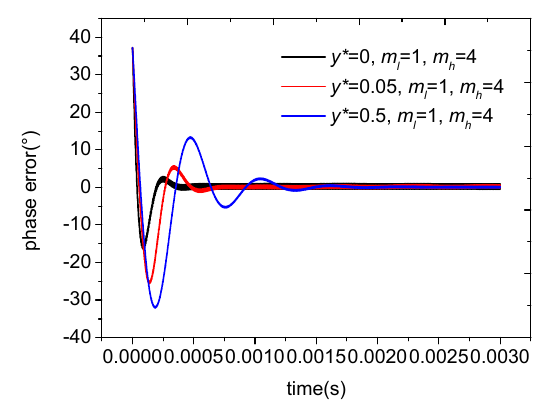
Figure 6. Phase error when y* changes.